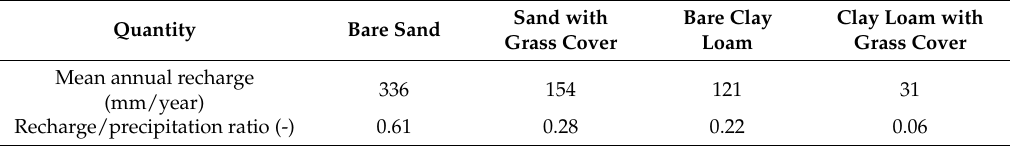
Table 2. Annual recharge and recharge/precipitation ratios obtained from numerical simulations.